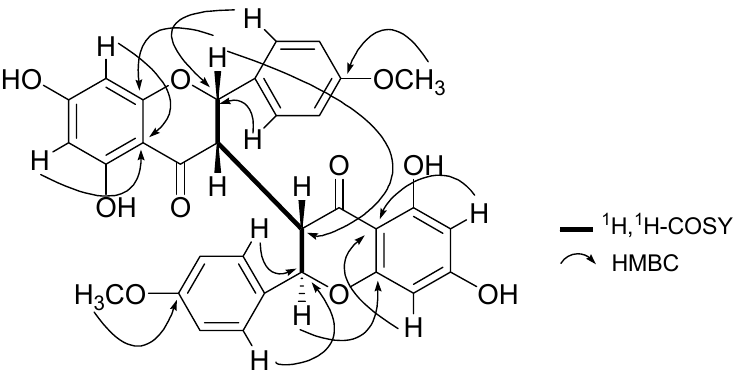
Figure 2. key 1 H- 1 H COSY and HMBC correlations of 1